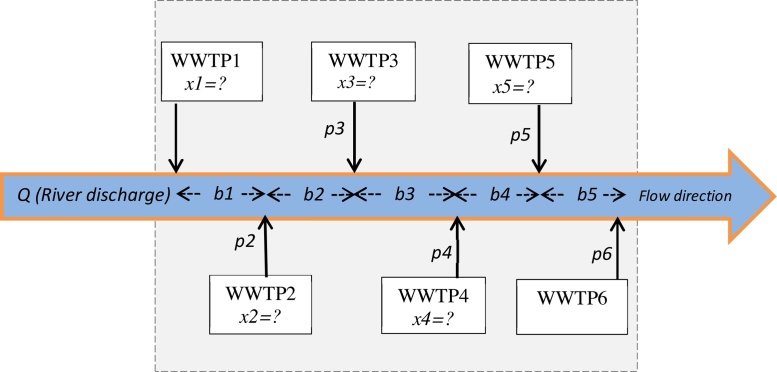
Schematic representation of the input/output parameters of the study problem.